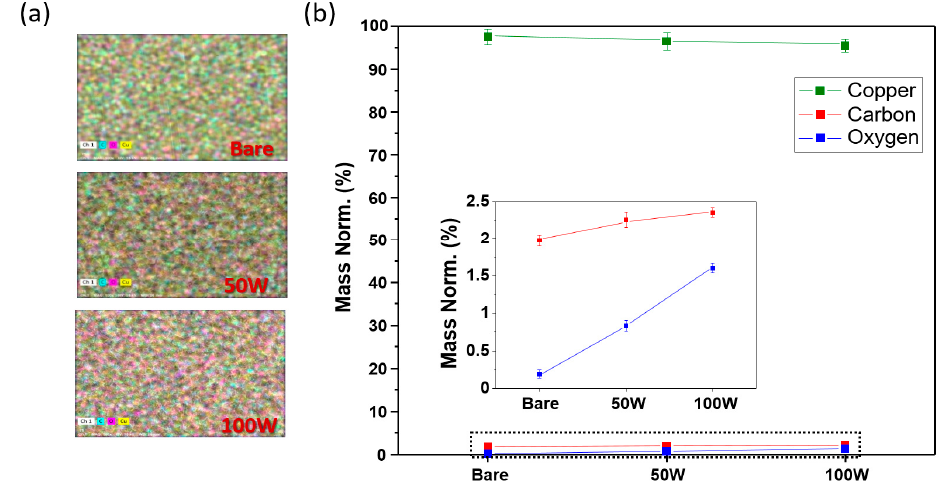
Figure 2. Electron probe microanalyzer (EPMA) and electron dispersive spectroscopy (EDS) data of copper, carbon, and oxygen on the Cu current collector after the laser ablations of 50 W and 100 W: ( a ) EPMA map; ( b ) EDS analysis.